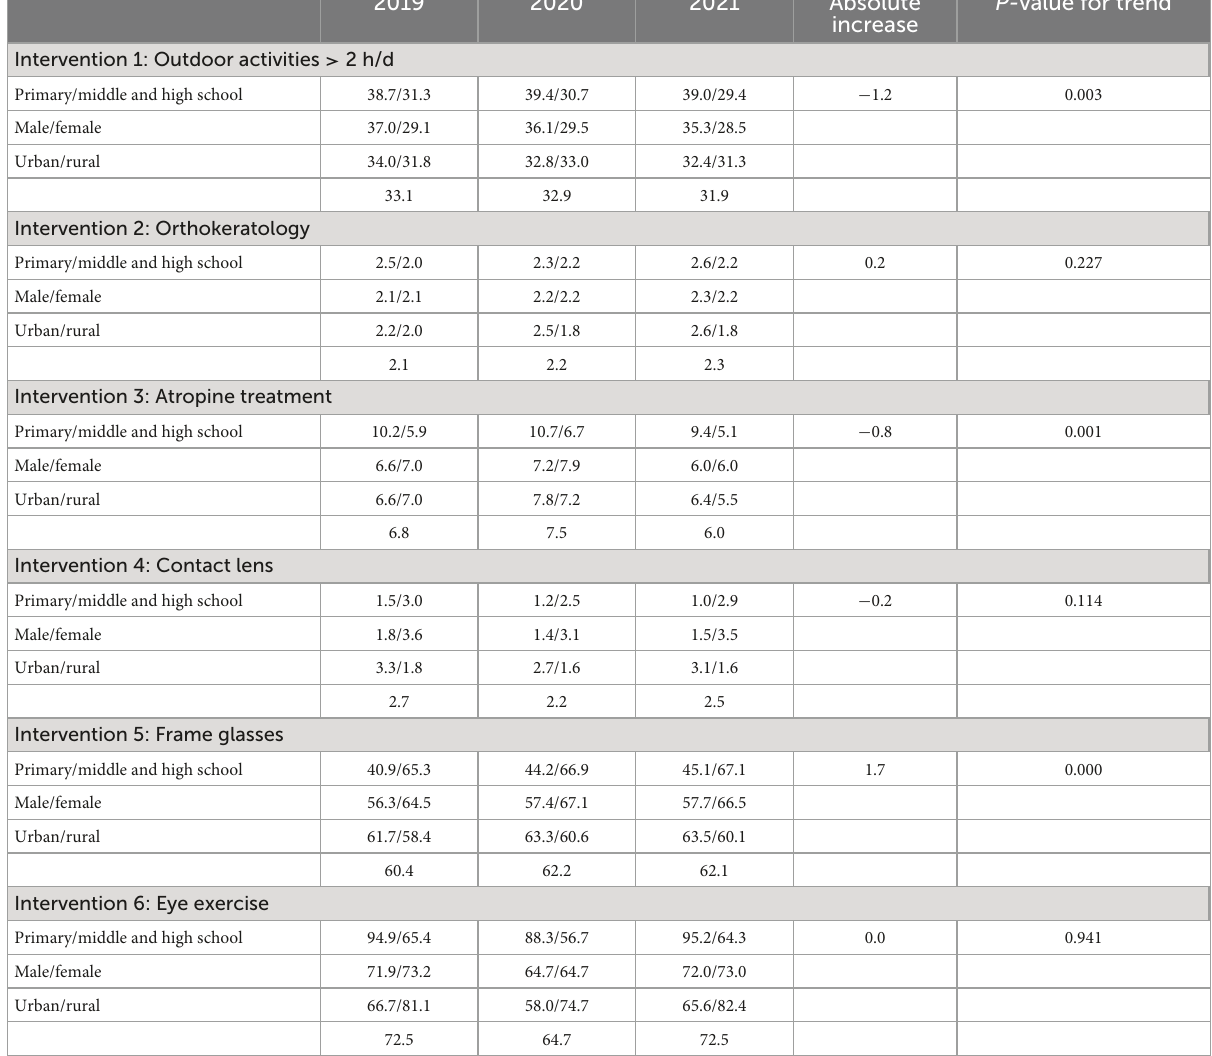
TABLE 2 Current myopic intervention utilization among myopic Chinese children and adolescents based on surveys from 2019, 2020, and